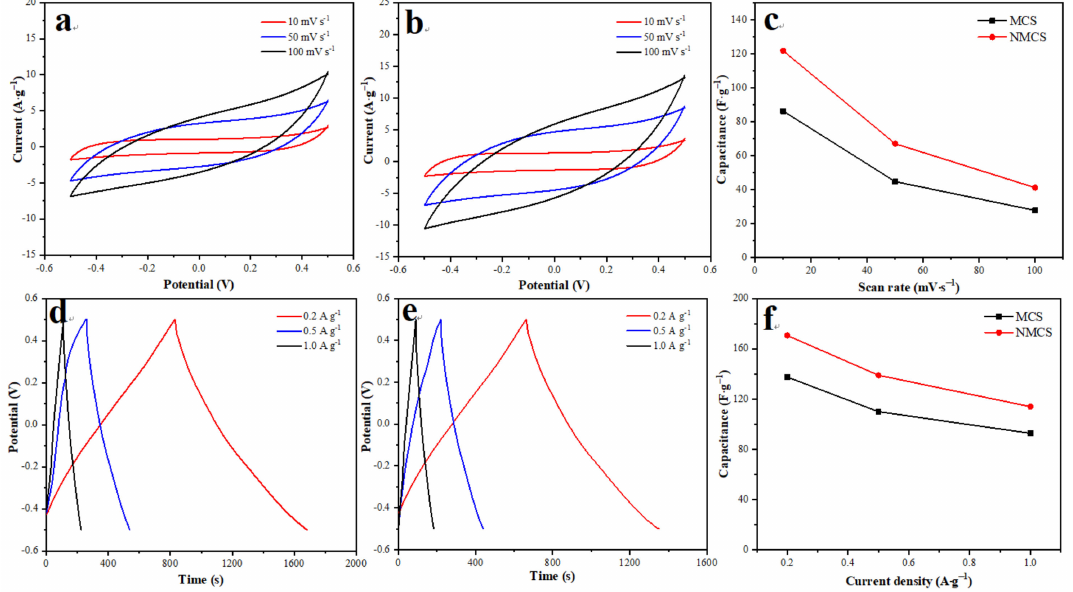
Figure 4. ( a ) CV curves of MCS with different scan rates; ( b ) CV curves of NMCS with different scan rates; ( c ) specific capacitance results of MCS and NMCS; ( d ) GCD curves of MCS with different current densities; ( e ) GCD curves of NMCS with different current densities; ( f ) charge/discharge capacitance results of MCS and